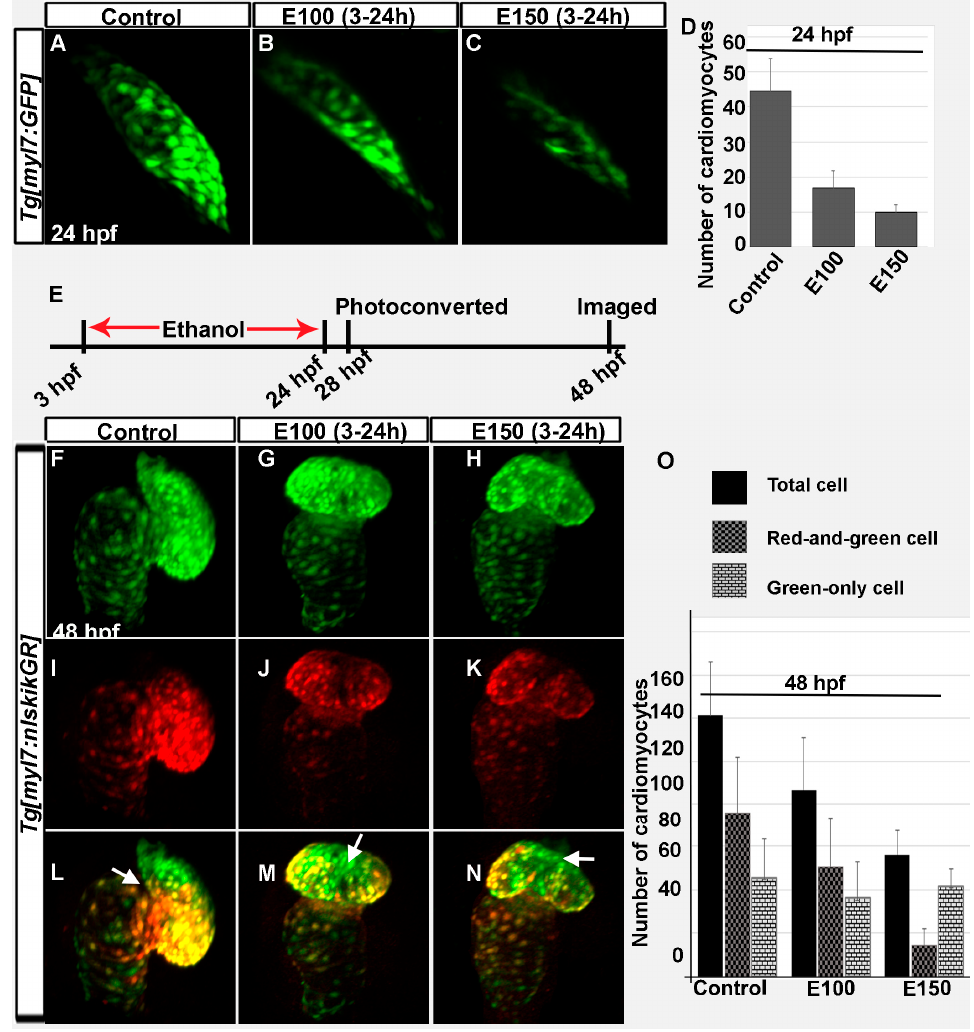
Figure 2. Ethanol exposure during embryogenesis reduced the number of early- and late-added cardiomyocytes in the heart. ( A – C ) 3D renderings of confocal sections of Tg ( myl7 : GFP ) embryos showed GFP positive FHF derived cardiomyocytes in the linear heart tube in the control ( A ) and ethanol-exposed embryos ( B , C ); ( D ) Graph shows reduced number of FHF derived cardiomyocytes in ethanol-exposed embryos at 24 hpf. p < 0.001; ( E ) Schematic shows the time of ethanol treatment, photoconversion, and image acquisition in this experiment; ( F – N ) 3D renderings of confocal sections of photoconverted Tg ( myl7 : nlskikGR ) embryos showed hearts in the control and ethanol-treated embryos. Note the green-only cardiomyocytes (cardiomyocytes added after photoconversion) in the anterior region of the ventricle in control embryos ( A , L ); but in the mid-ventricular region in ethanol-treated embryos ( G – N ); White arrows: green-only cells; ( O ) Graph shows the quantification of total, red-and-green (early-added cardiomyocytes) and green-only (late-added cardiomyocytes) cardiomyocytes at 48 hpf.